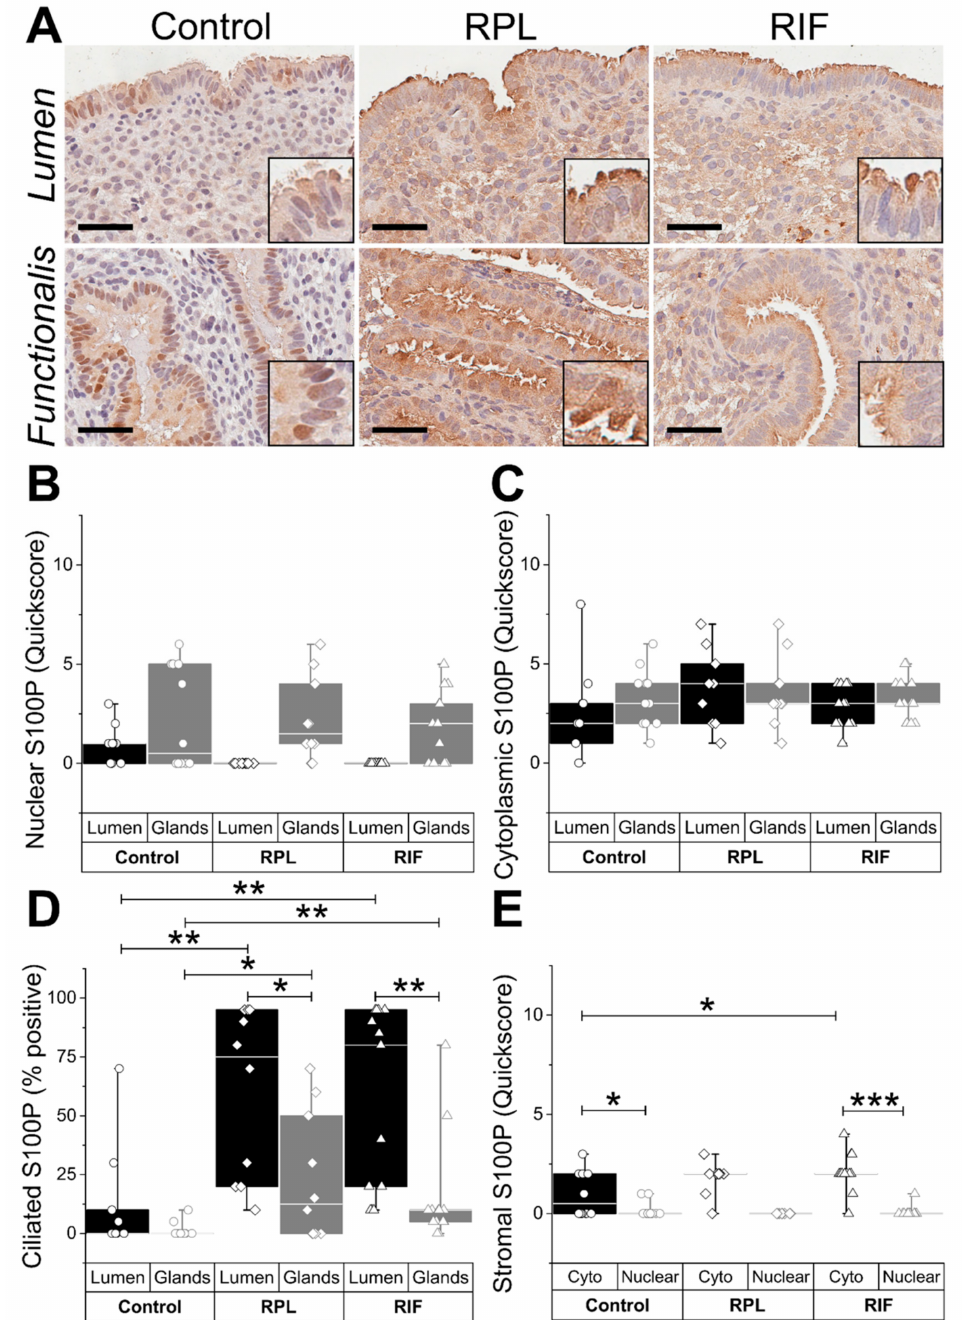
Figure 3. Endometrial S100P expression in control and recurrent reproductive failure. ( A ) Represen- tative micrographs demonstrate S100P immunostaining in endometrial tissue from fertile (control), recurrent pregnancy loss (RPL), and recurrent implantation failure (RIF) patients. Scale bar 50 µ m. Immunostaining scores for ( B ) nuclear, ( C ) cytoplasmic, and ( D ) ciliated S100P expression in the luminal and glandular epithelium. ( E ) Immunostaining scores for nuclear and cytoplasmic S100P expression in endometrial stroma * p < 0.05, ** p < 0.01, and *** p <